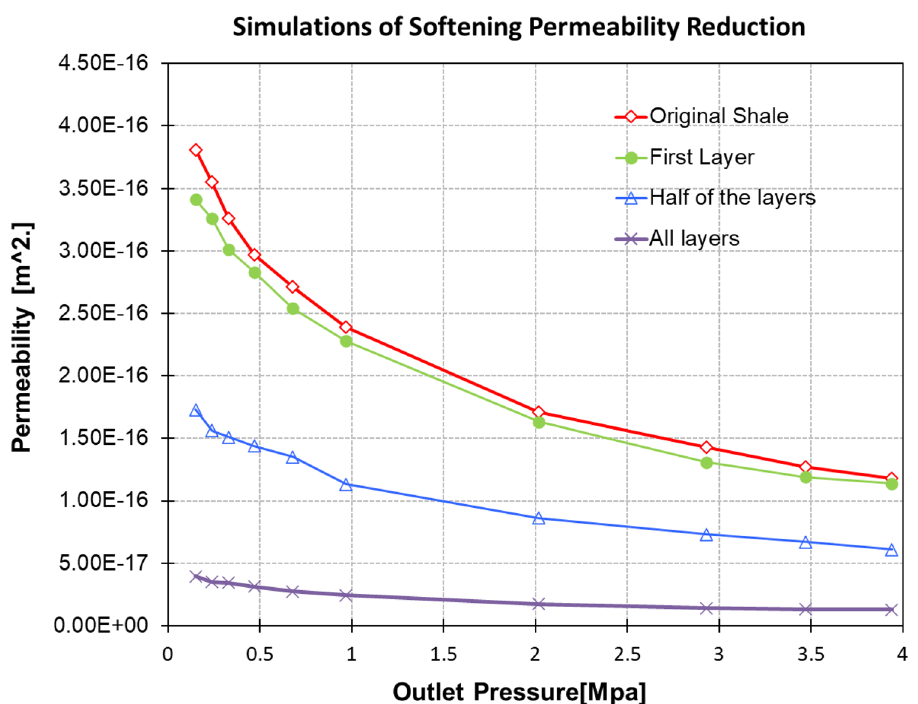
Figure 11. Permeability for different conditions of